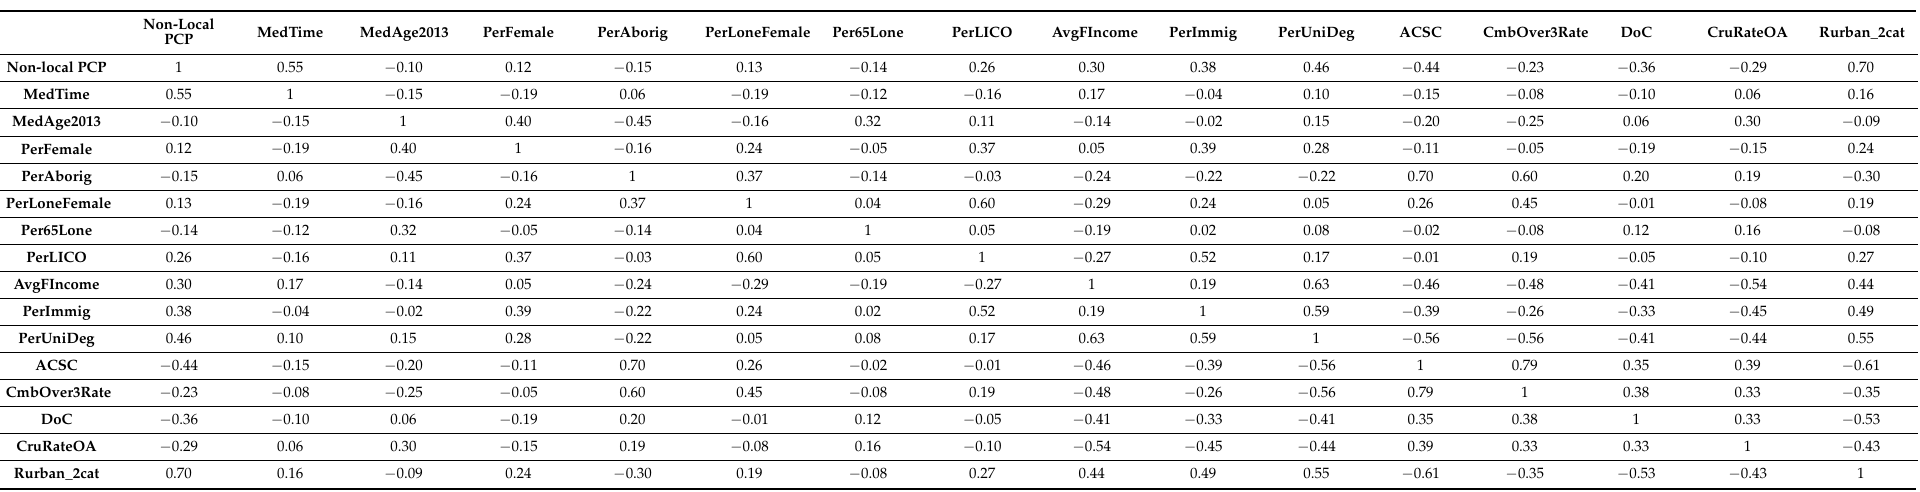
Table 2. Correlation coefficients between